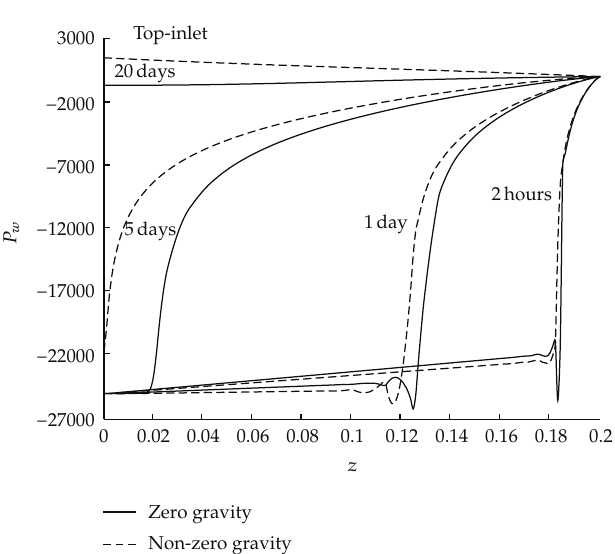
Figure 10: Comparison between considering and neglecting gravity e ff ect on water pressure for the top- inlet case, at x (cid:8) 0 . 1m.